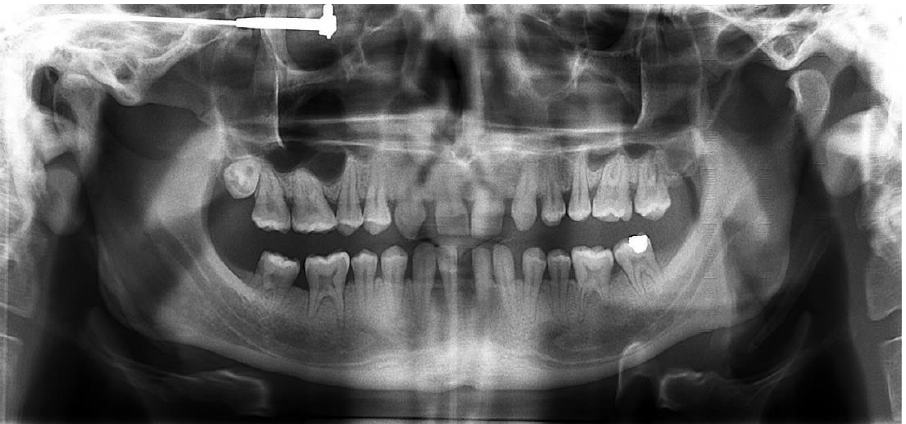
Figure 3. Orthopantomogram of the patient’s initial dental condition in February 2021.